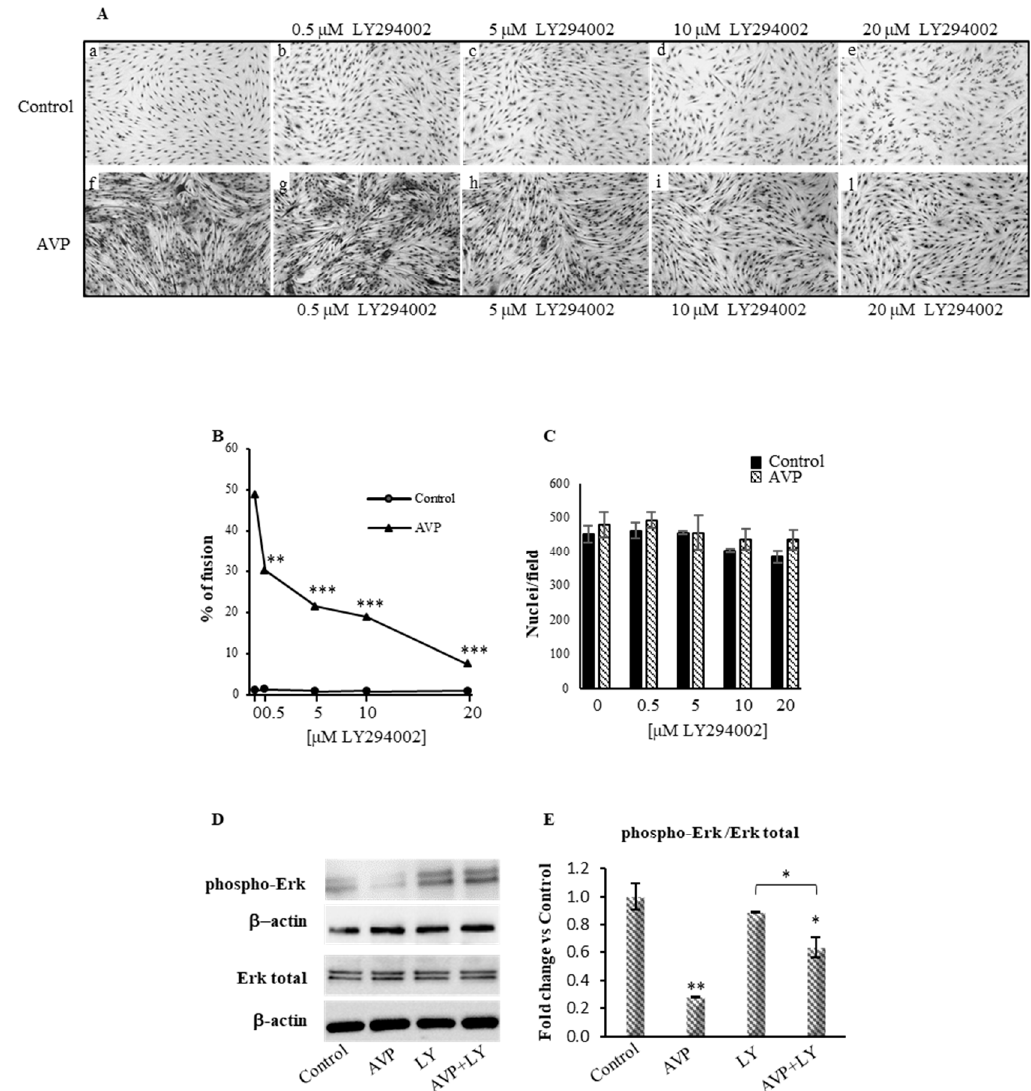
Figure 1. Effects of LY294002 on the vasopressin (AVP)-dependent myogenic differentiation. ( A ) Morphological analysis of L6 cells cultured in growth medium, shifted in serum-free medium after 24 h and treated with increasing concentrations of LY294002 (0, 0.5, 5,10 and 20 µM) in the absence ( a – e ) or in the presence of 0.1 µM AVP ( f – l ). After a 6-day treatment, morphological differentiation was evaluated by May-Grünwald Giemsa staining (original magnification, 10×). ( B ) In similarly prepared cultures of L6 cells, nuclei were counted under the microscope and the ratio between the number of nuclei in myotubes versus the total number of nuclei per microscopic field, in both LY294002 and AVP + LY294002 treated cells, were expressed as the percentage of fusion and ( C ) as the total (fused and unfused) nuclei/microscopic field. Each experimental point represented in the graphs is the mean ± SD of the counts evaluated from three to five independent samples obtained in three separate experiments. ( D ) Western blot analysis of phospho-p44/42 and total p44/42 expression performed after 48 h of culture. ( E ) Densitometric analysis was achieved using an anti- β -actin antibody to verify the equal loading of the samples. Statistical analysis was performed using Student’s t -test. * p < 0.05; ** p < 0.01; *** p < 0.001. For Figure 1B * vs. AVP; for Figure 1F # vs. AVP; for Figure 1E * vs. Control and # vs. LY294002.